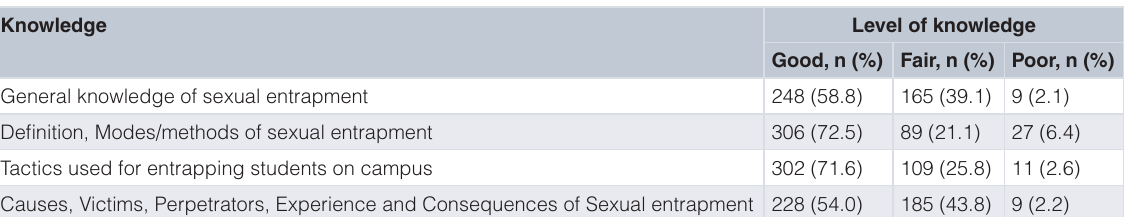
Table 2. Knowledge on different aspects of Sexual entrapment